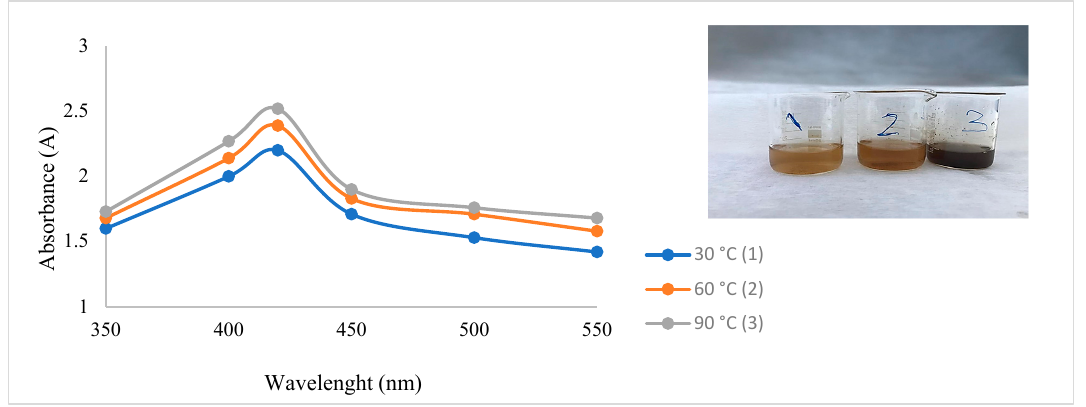
Figure 1. UV spectrum of CH-AgNPs after 30 min.